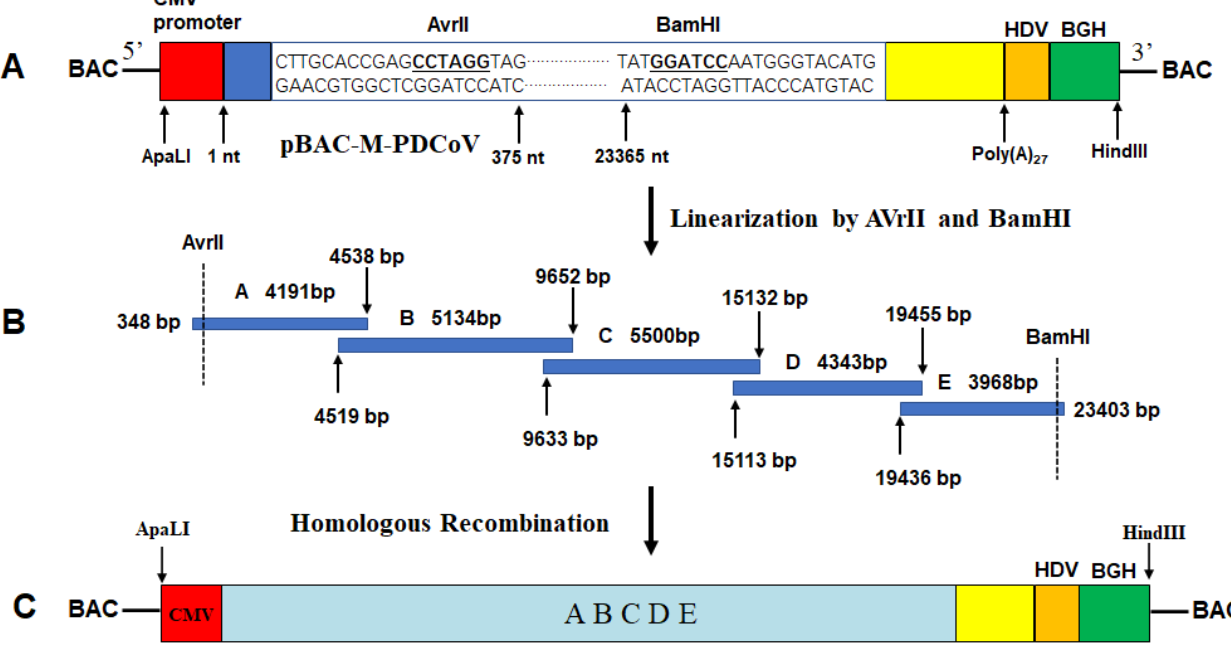
Figure 1. Assembly of a full-length cDNA clone of PDCoV CHN-HN-2014. ( A ) Schematic diagram of the intermediate plasmid pBAC-M-PDCoV. A gene fragment obtained by multi-step fusion PCR, containing CMV promoter, a partial N-terminal region of PDCoV genome (nt 1–375), a partial C-terminal region of PDCoV genome (nt 23,365–25,421), a 27-nt poly(A) tail, the hepatitis deltavirus (HDV) sequence, and the bovine growth hormone (BGH) termination sequences, was cloned into the backbone vector pBeloBAC11 between the restriction sites ApaLI and HindIII. The critical restriction sites and their relative positions in the genome of the PDCoV strain CHN-HN-2014 are indicated. ( B ) Five contiguous genomic overlapping overhangs were amplified and assembled into pBAC-M-PDCoV by homologous recombination. ( C ) Schematic diagram of the full-length cDNA clone of CHN-HN-2014 in the pBeloBAC11 vector, referred to as pBAC-CHN-HN-2014.